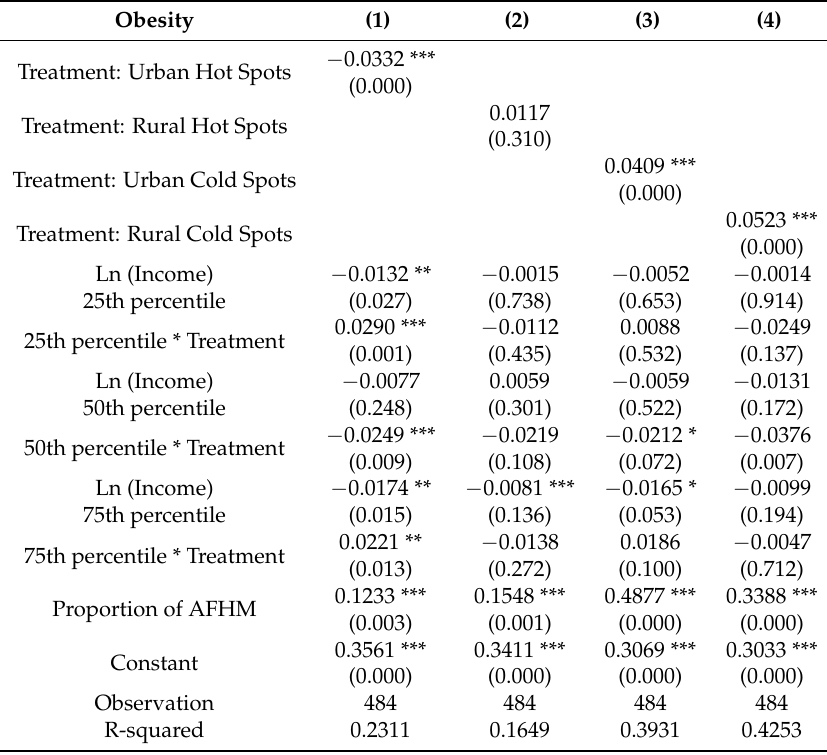
Table A6. Propensity score weighting results for obesity.